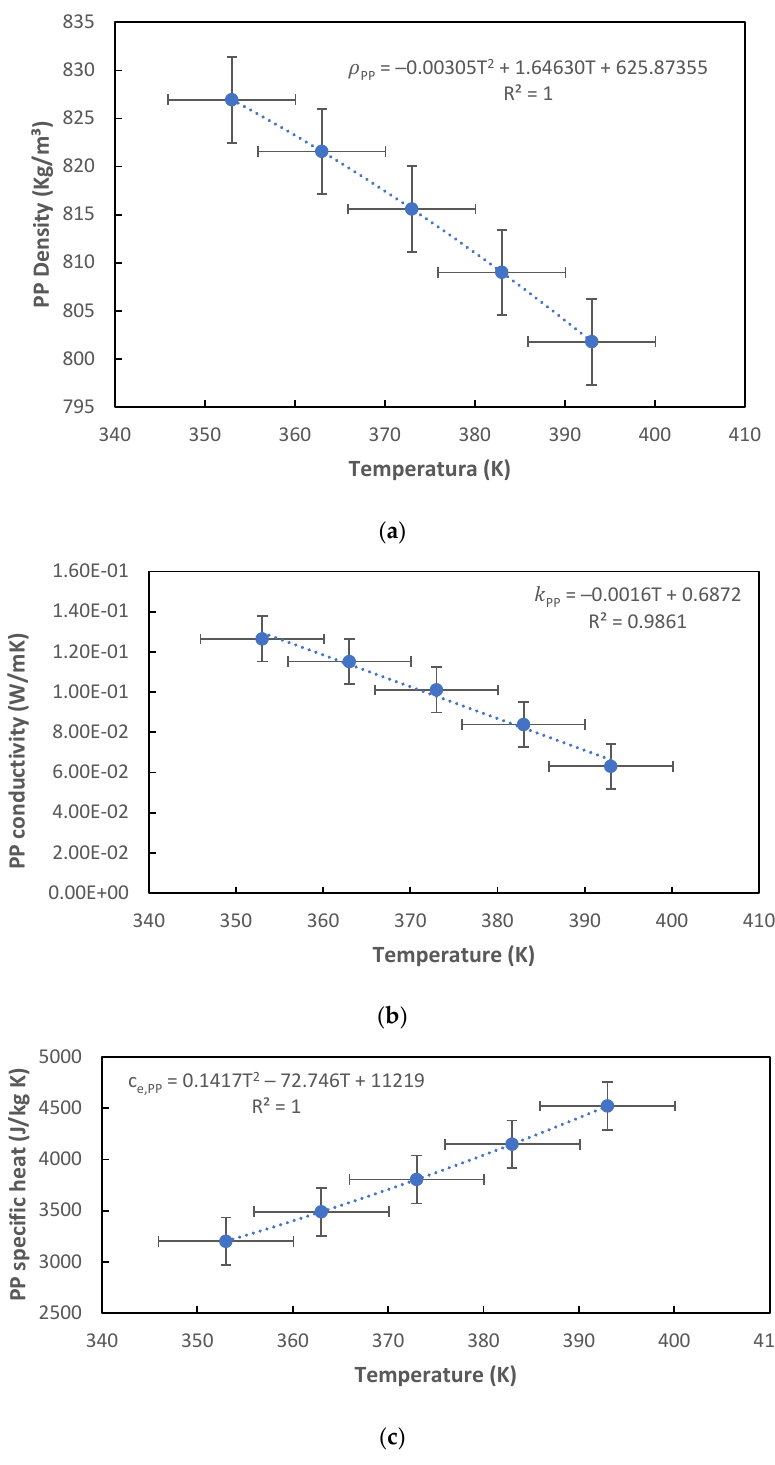
Figure 7. PP relation between material properties and temperature. ( a ) Density, ( b ) Thermal conduc- tivity, and ( c ) Specific